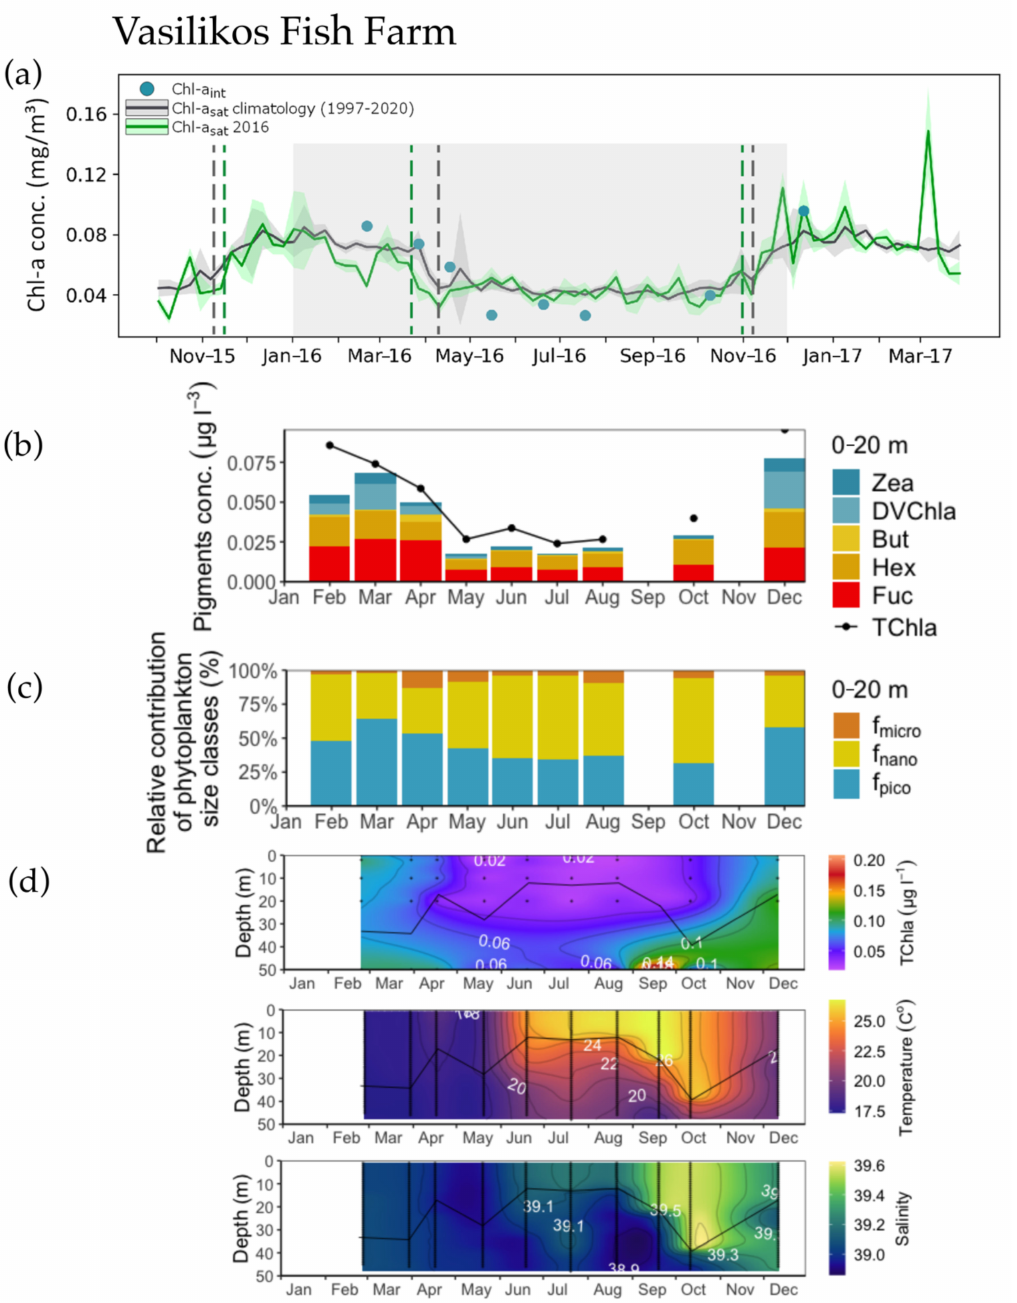
Figure 4. Time series of satellite-derived Chl-a consecrations, diagnostic pigment concentrations and vertical profiles of total Chl-a, temperature, and salinity in Vasilikos Fish Farm (VAS) station. ( a ) Climatology time-series (based on 23-year OC-CNR data of daily composites) (Chl-a sat climatology (1997–2020) in comparison with satellite-derived Chl-a concentration from October 2015 to March 2017 (Chl-a sat 2016). Blue dots represent the in situ measurements (Chl-a int ) taken between January and December 2016 (shaded area). The dashed lines represent the timing of initiation and termination of the main phytoplankton growth, ( b ) Diagnostic pigments concentrations for the 0–20 m layer, ( c ) Percentages associated with the pico- (fpico), nano- (fnano) and micro-phytoplankton (fmicro) size classes, for the 0–20 m layer, ( d ) Vertical profiles of CTD temperature, salinity, and HPLC total Chl-a concentration. The black line represents the Mixed-Layer Depth (MLD). Note: The in situ data are a snapshot (one day in each month) compared to the weekly averages of the satellite retrieved